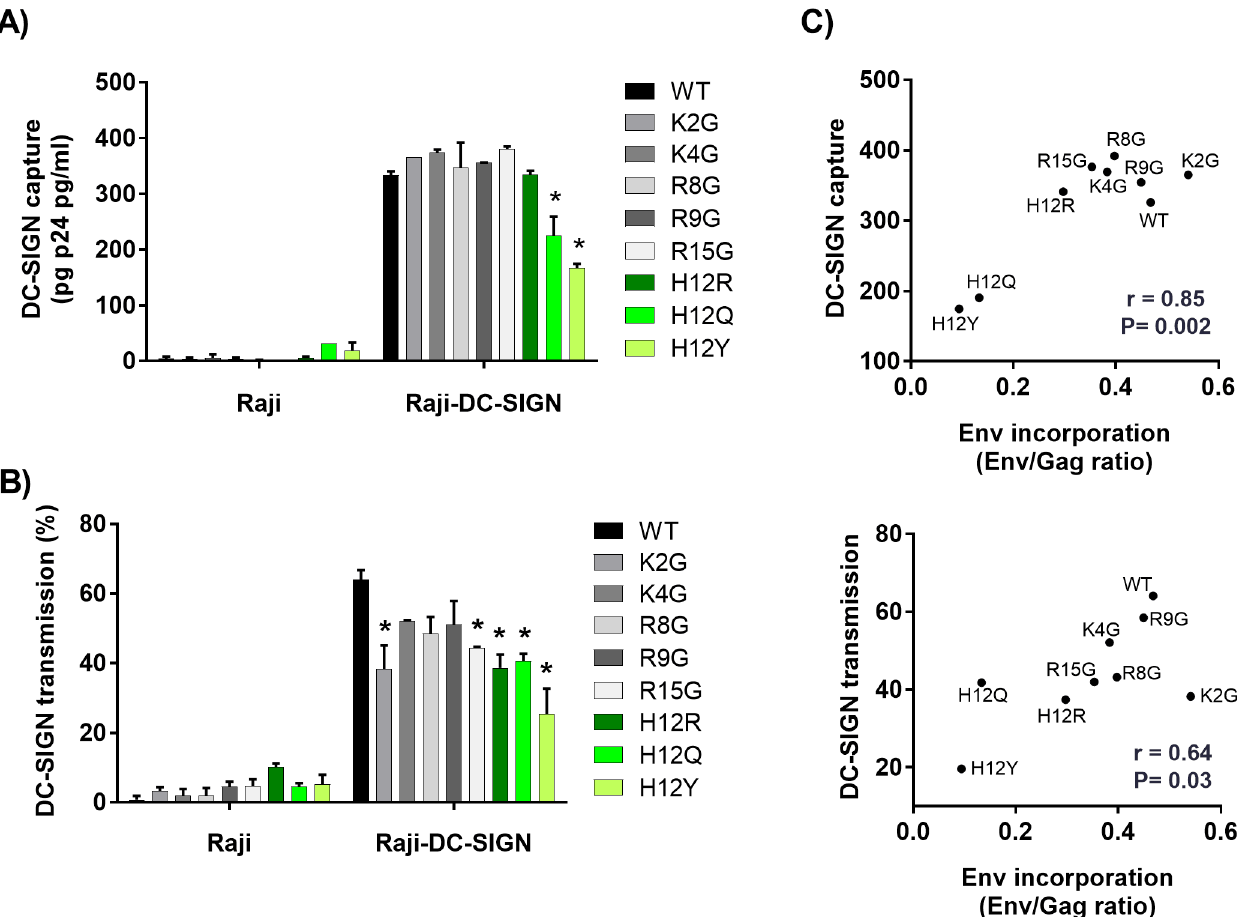
Fig 5. Effects of SP mutations on REJO virus capture and transmission by DC-SIGN. (A) Parental Raji or Raji–DC-SIGN + cells were incubated for 2 hours with WT or mutant viruses produced in 293T cells. Cells were washed extensively, and the amounts of p24 protein associated with the cells were measured by ELISA. (B) Parental Raji or Raji–DC-SIGN + cells were incubated with WT and mutant viruses for 2 hours, washed to remove unbound viruses, and added to CD4+ TZM.bl cells. Viral transmission to the TZM-bl cells was determined by luciferase activity and calculated based on infection in TZM.bl cells without Raji cells as control (set to 100%). Background luciferase activity was determined in co-cultures without any virus. (cid:3) , p < 0.05 as compared to WT (ANOVA). (C) Correlation of virus capture (top) and transmission (bottom) via DC-SIGN with the Env incorporation into the WT and mutant virions by Spearman’s rank